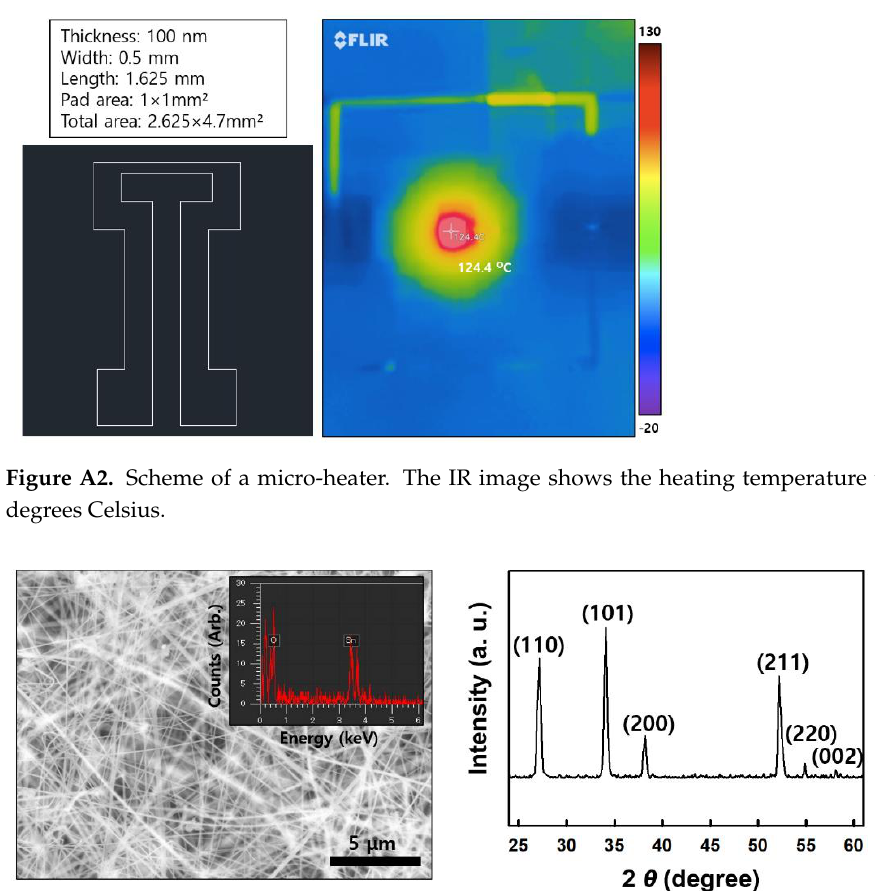
Figure A1. Photographs of the detailed fabrication procedure of a wireless micro-heater consisting of an Al antenna and a Pt micro-heater.